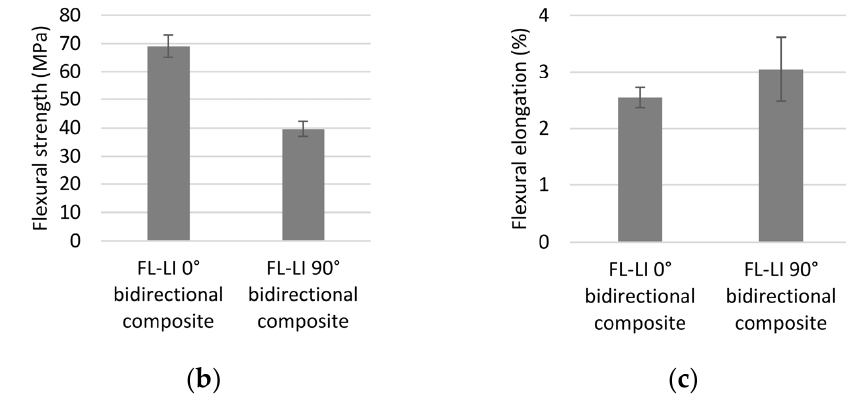
Figure 13. ( a ) Flexural modulus of FL-LI composites; ( b ) flexural strength of FL-LI composites; ( c ) elongation of FL-LI composites. ( c ) elongation of FL-LI